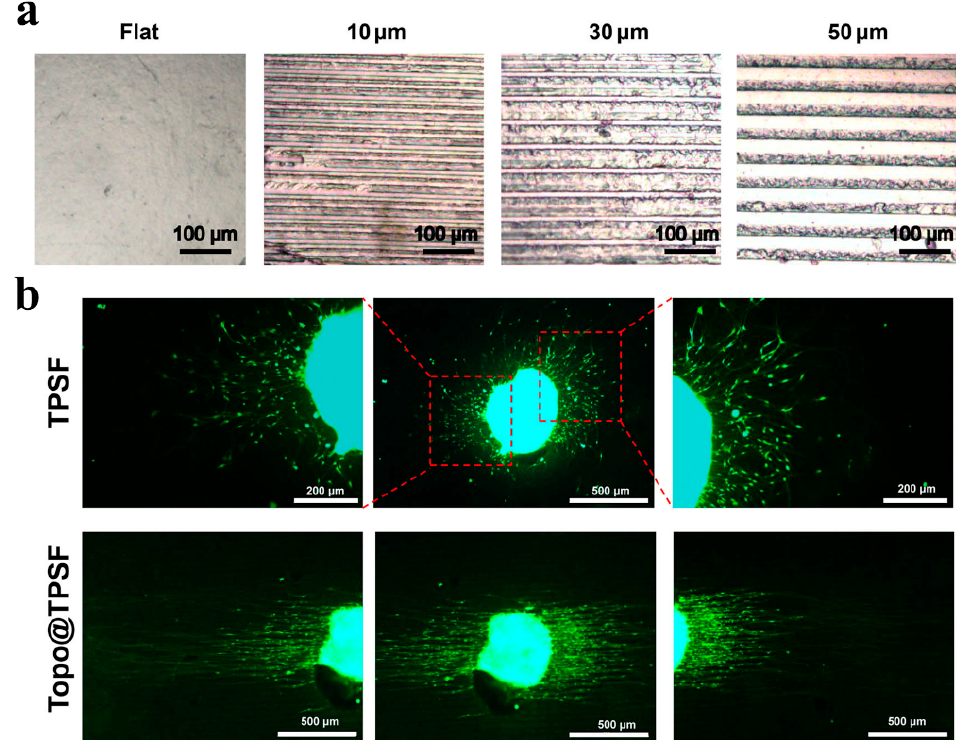
Figure 8. The hydrogels with a stable aligned micropattern have great potential for peripheral nerve regeneration [77]. ( a ) Microscopic images of microgrooves arranged on the surface of hydrogels; ( b ) fluorescence images of dorsal root ganglion cultured on TPSH (tough pure-silk fibroin hydrogels) and Topo@TPSF (micropatterned pure-silk fibroin hydrogels) after 3 days of incubation. (Adapted with permission from Ref. [77]. 2021, De Gruyter).